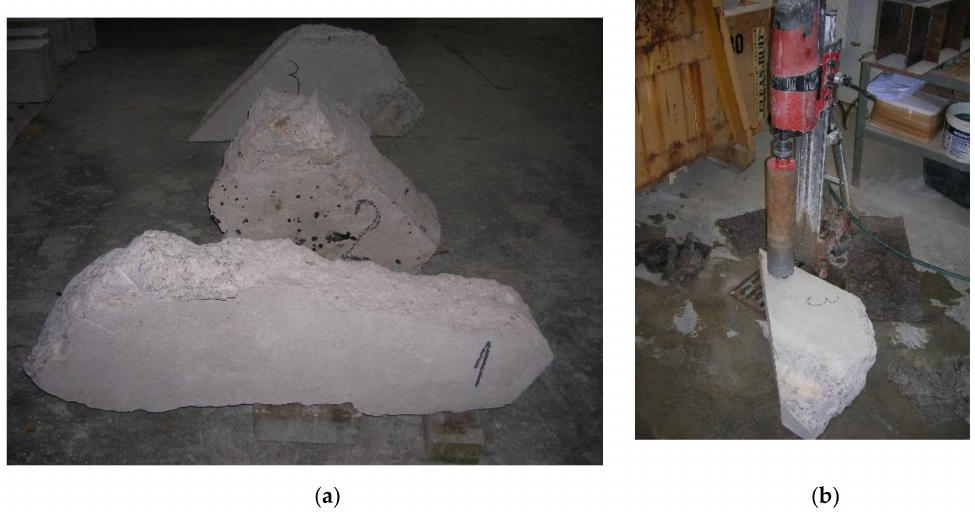
Figure 3. Preparation of the concrete cores: ( a ) Fragments of old concrete; ( b ) drilling